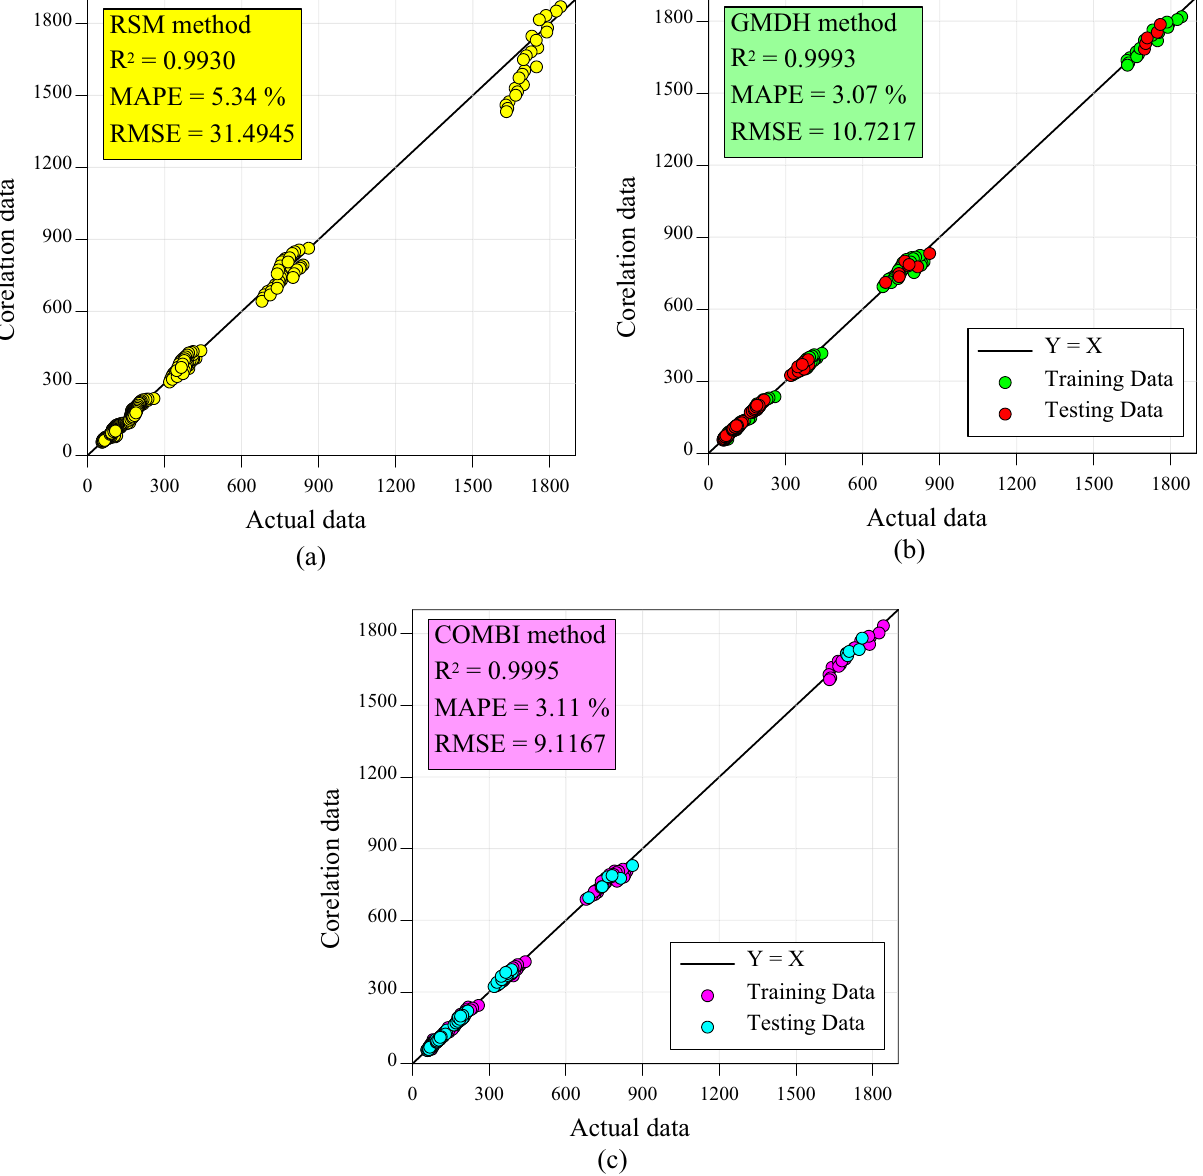
Figure 12. Comparison between experimental data with correlation outputs of ( a ) RSM model, ( b ) GMDH- type ANN model, and ( c ) COMBI algorithm.